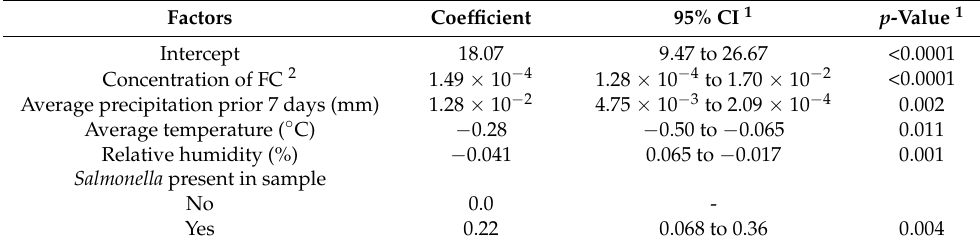
Salmonella present in sample No 0.0 Table 4. Mixed-effects negative binomial regression model for factors associated with the concentration adjusted for potential intra-group correlation within four oyster sampling locations. 2 FC = fecal of E. coli in estuarine water from Phang Nga Bay, southern Thailand, March 2016 to February 2017. coliforms (MPN/g of pooled oyster meat). Factors Coefficient 95% CI 1 p -Value 1 Intercept Concentration of FC 2 Average precipitation prior 7 days (mm) Akaike Information Criteria (AIC) = 981.05. 1 The 95% confidence interval (CI) and p -values were adjusted for potential intra-group correlation within oyster sampling locations; 2 FC = fecal coliforms (MPN/100 mL of estuarine